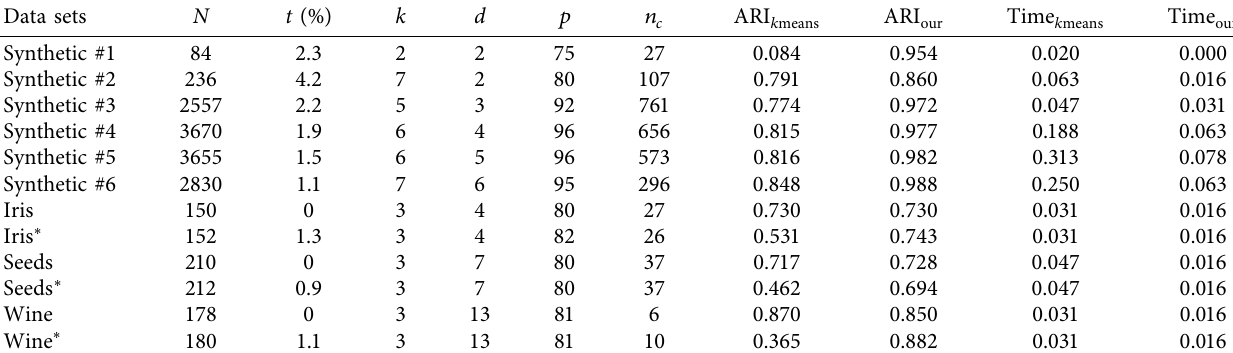
Table 1: Comparison between k -means clustering algorithm and our proposed clustering algorithm.